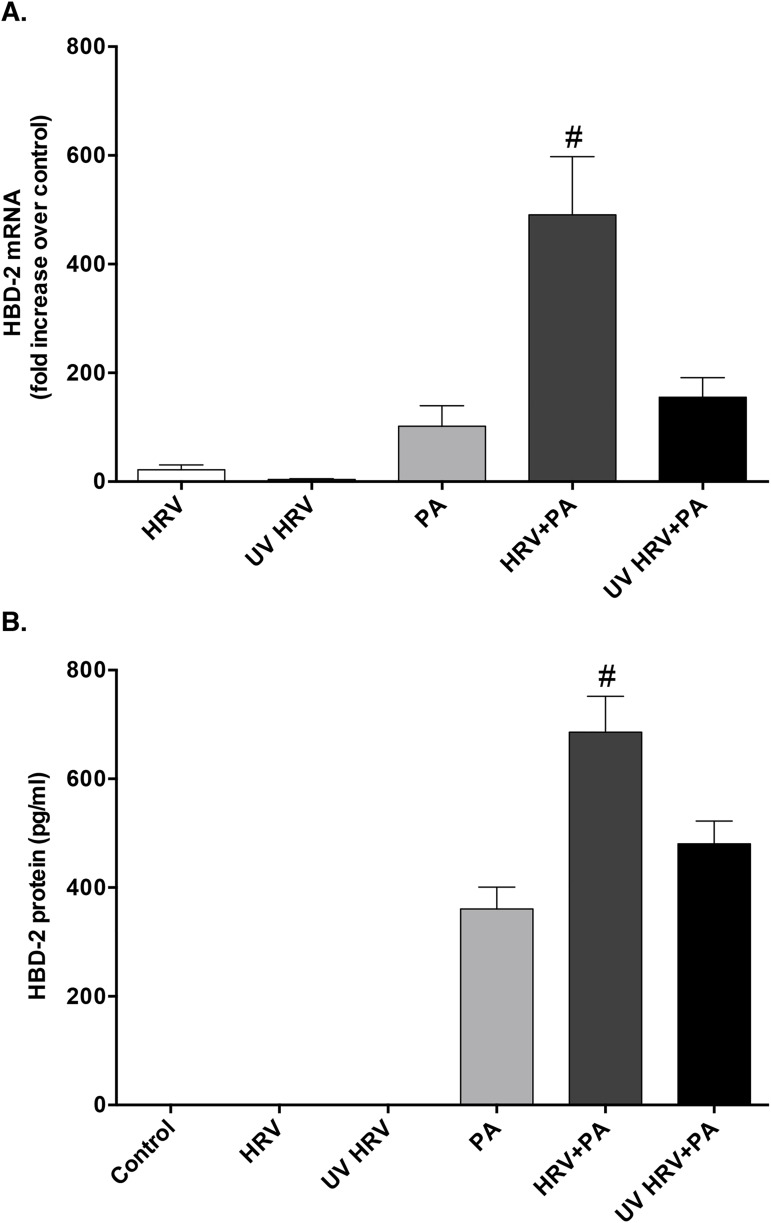
Synergistic expression of HBD-2 is lost after co-infection with replication deficient UV-treated human rhinovirus (UV HRV) and P. aeruginosa (PA).A) HBD-2 mRNA (n = 4) and B) protein (n = 8) expression from HBE cells after 48 h infection with HRV, PA, UV-HRV, or the combination of PA with either virus group. Data are expressed as mean ± SEM (#p<0.05 compared to all other treatment.